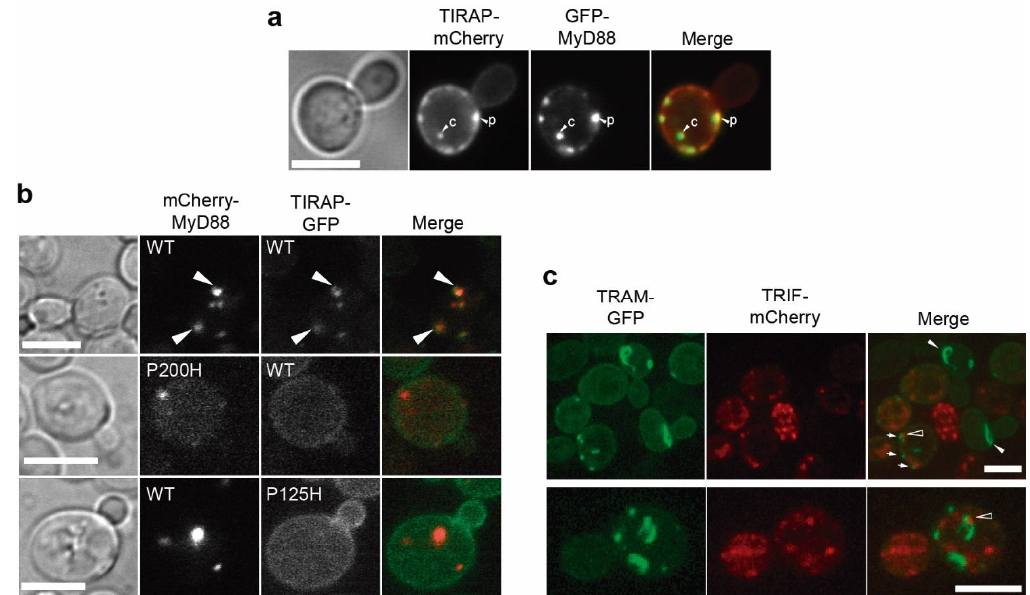
Figure 7. Co ‐ expression of human TIR adaptor pairs. ( a ) Bright field and fluorescence microscopy of YPH499 yeast cells co ‐ transformed with pYES3 ‐ TIRAP ‐ mCherry and pYES2 ‐ GFP ‐ MyD88 . White arrows indicate co ‐ localization events on cytosolic spots “c” or PM patches “ p ”. ( b ) Bright field and fluorescence microscopy of YPH499 yeast cells co ‐ expressing mCherry ‐ MyD88 from pYES3 and TIRAP ‐ GFP from YCpLG, either WT or the indicated mutants. Co ‐ localization occurs only in the WT and is marked with arrowheads. ( c ) Laser confocal microscopy of YPH499 cells expressing TRAM ‐ GFP from YCpLG and TRIF ‐ mCherry from pYES3. Images are maximum Z projection stacks of 12 (upper panel) and 13 (lower panel) confocal planes. Small arrows point TRAM ‐ GFP non ‐ filamentous patches, white arrowheads mark long TRAM ‐ GFP filaments in cells lacking TRIF ‐ mCherry signal, and hollow arrowheads indicate minor TRIF ‐ mCherry spots that were located adjacent to TRAM ‐ GFP spots. Scale bars represent 5 μ m.